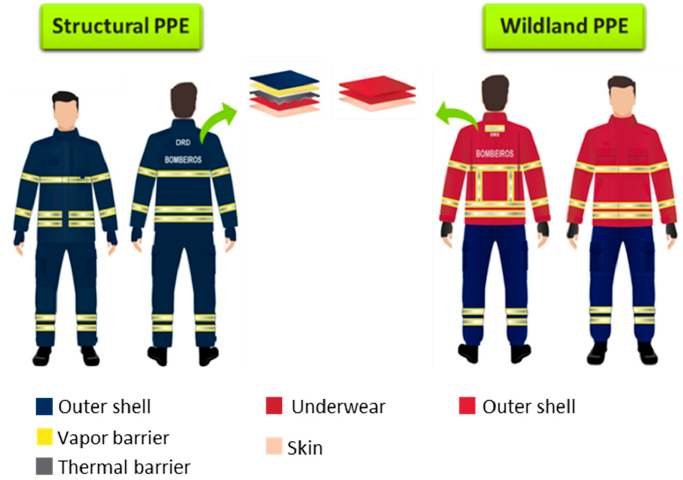
Figure 1. Structural and wildland PPE according to dispatch 7316/2016. Table 1. Comparison between the minimum compliance values for wildland and structural firefight- ing protective clothing, which used the same test